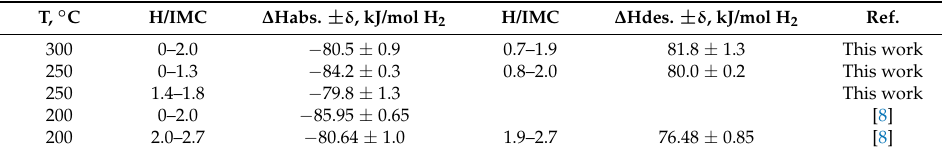
Table 1. Table 1. The values of hydrogen absorption and desorption enthalpy in the Nd 2 Fe 17 -H 2 system. T, ◦ C H/IMC ∆ Habs. ± δ , kJ/mol H 2 H/IMC ∆ Hdes. ± δ , kJ/mol H 2 Ref. 300 0–2.0 − 80.5 ±